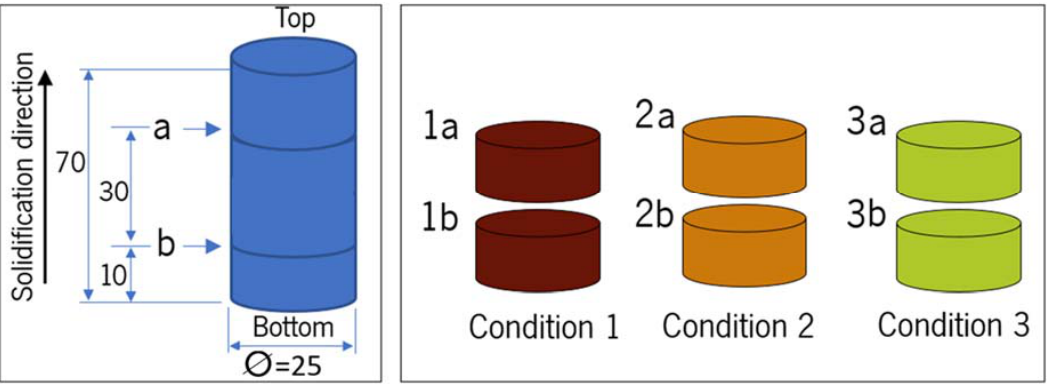
Figure 4. Sample characterization of cast specimens and samples for microstructural characterization.